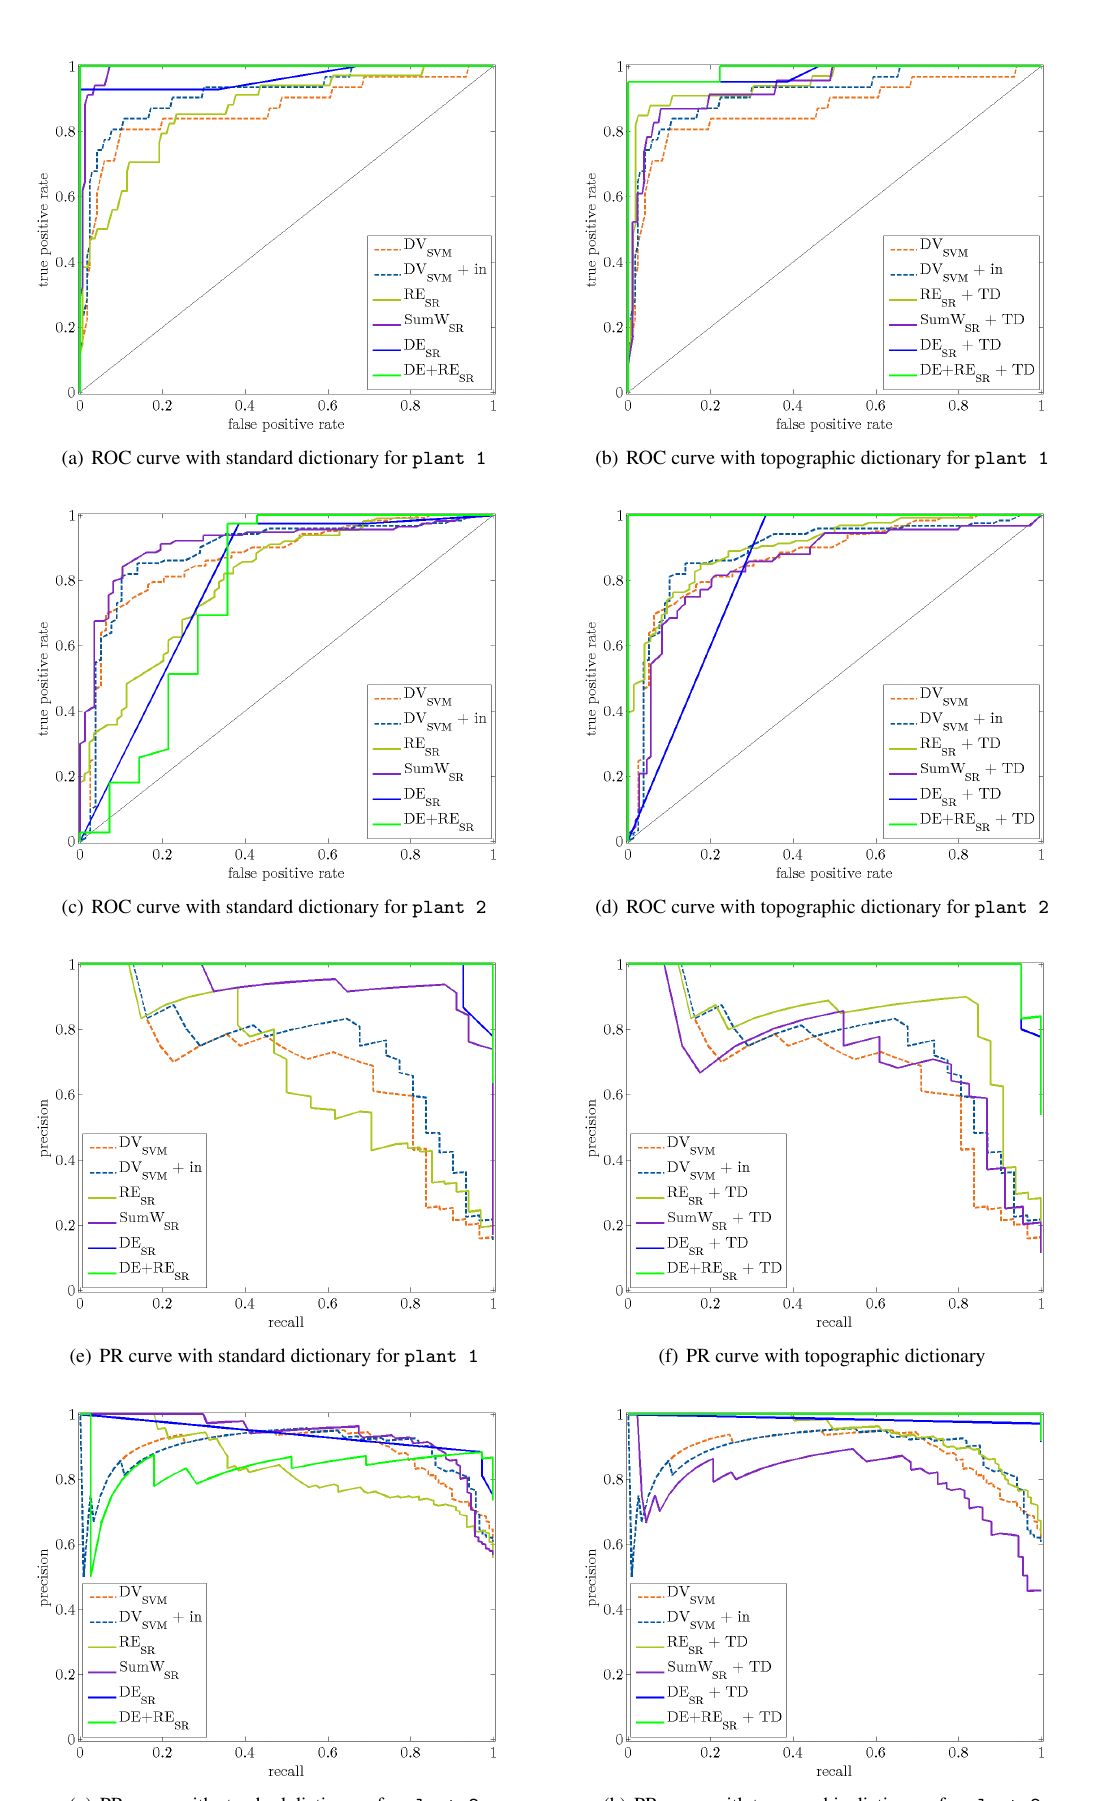
Figure 7: Receiver operator characteristics (ROC) and precison-recall (PR) curves for plant 1 and plant 2 . For comparison, the same curves of the OCSVM were added to the fi gures with and without topographic